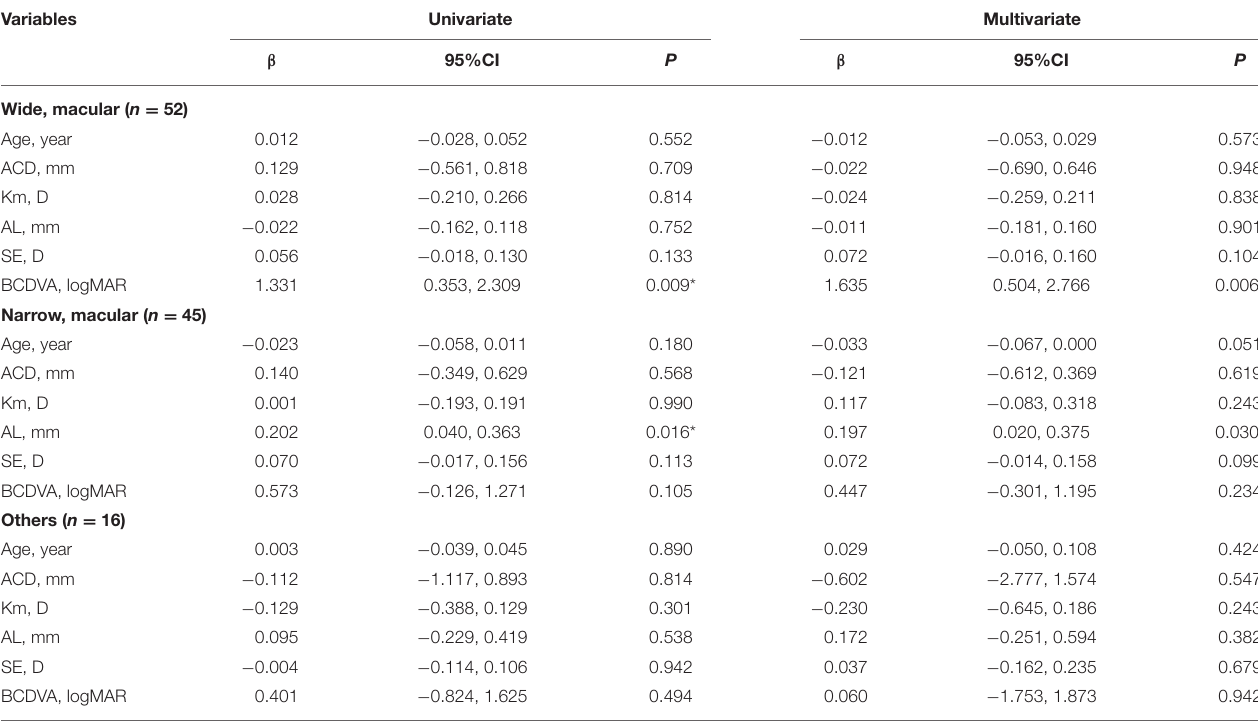
TABLE 4 | Impact of risk factors on postoperative refractive errors in wide macular, narrow macular, and other types of posterior